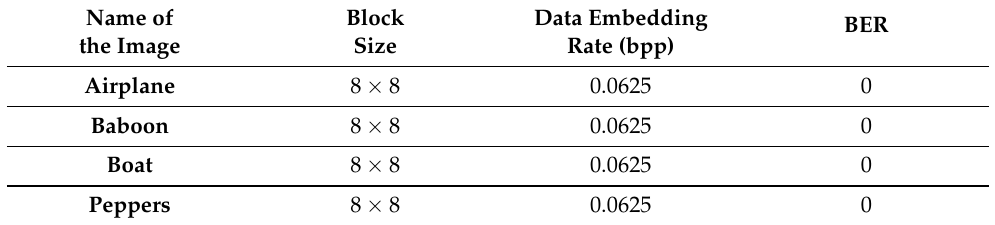
Table 2. Rate of information embedded and bit errors on airplane, baboon, boat and peppers images.